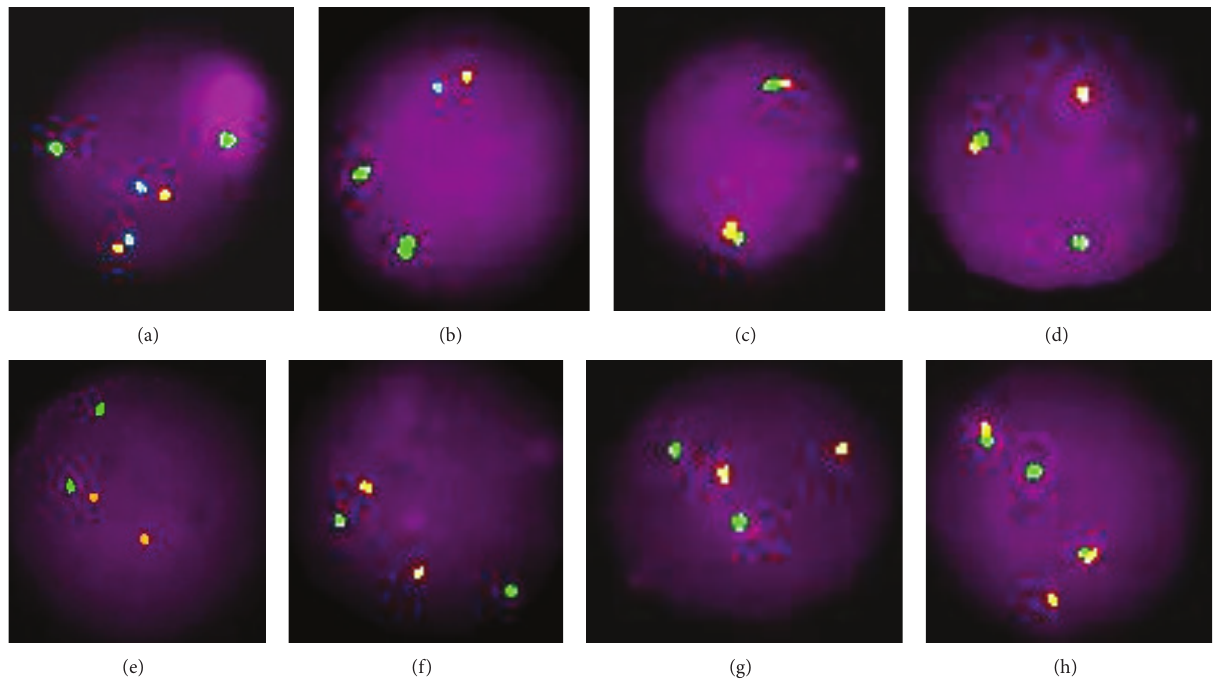
F 1: FISH images of normal and abnormal cells using various probes. (a) A normal cell showing 2 green (G), 2 orange (O) and 2 aqua (A) signals for chromosome 12 and loci 13q14.3 and 13q34 on chromosome 13, respectively, using Vysis CLL probe set for CEP12, 13q14.3 and 13q34. (b) A cell showing 2G1O1A signal pattern indicating monosomy 13 using Vysis CLL probe set for CEP12, 13q14.3, and 13q34. (c) Normal cell showing 2 fusion (F) signals for IGH locus (14q32) using Vysis IGH break-apart rearrangement probe. (d) A cell showing 1G1O1F signal pattern indicating IGH rearrangement at 14q32 using Vysis IGH break-apart rearrangement probe. (e) A normal cell showing 2 green and 2 orange signals for chromosomes 11 and 17, respectively, using Vysis CLL probe set for 11q23 (ATM) and 17p13.1 (p53). (f) A normal cell showing 2 orange and 2 green signals for chromosomes 4 and 14, respectively, using Vysis LSI IGH-FGFR3 dual colour dual fusion translocation probe. (g) A normal cell showing 2 green and 2 orange signals for chromosomes 14 and 16, respectively, using Vysis LSI IGH-MAF dual colour dual fusion translocation probe. (h) A cell showing 1G1O2F signal pattern indicating IGH-MAF fusion for t(14;16) using Vysis LSI IGH-MAF dual colour dual fusion translocation